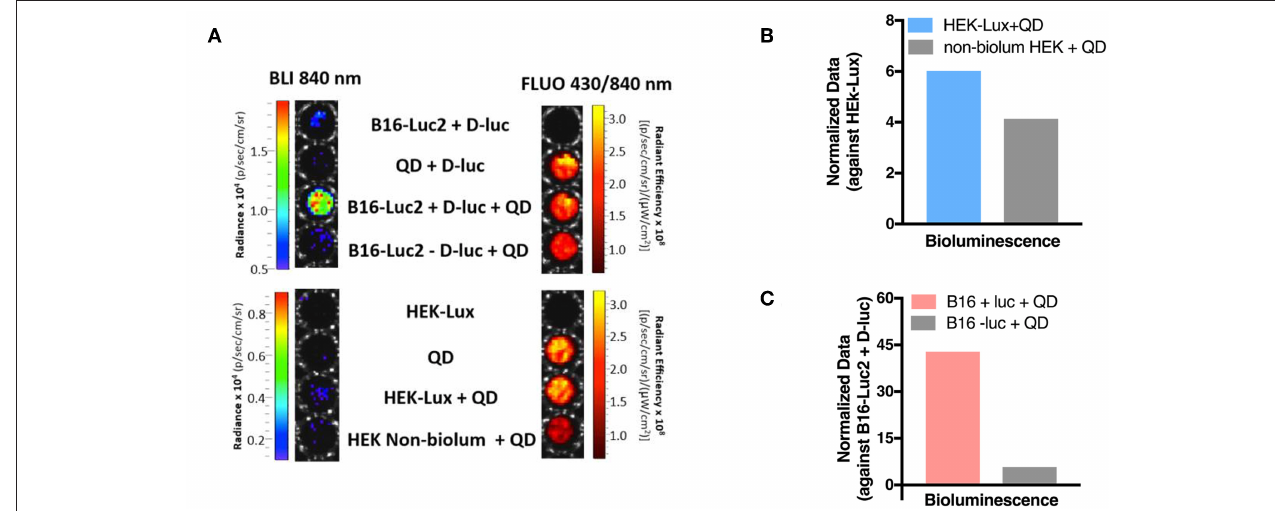
FIGURE 5 | In vitro investigation of FUEL with NIR QDs. (A) Bioluminescence (840nm, exposure time of 60s (B16-Luc 2 cells) and 180s (HEK-Lux cells), as well as fluorescence images (excitation 430nm, emission 840nm, and exposure time of 1s). (B) Quantitation of bioluminescence signal emitted at 840nm. Results are expressed as normalized SSMD values for B16-Luc2 cells (B16-Luc2 cells + D-luciferin used as control) or (C) HEK-Lux (or non-bioluminescent HEK used as control). n = 8 (except for HEK-Lux + QD – n =